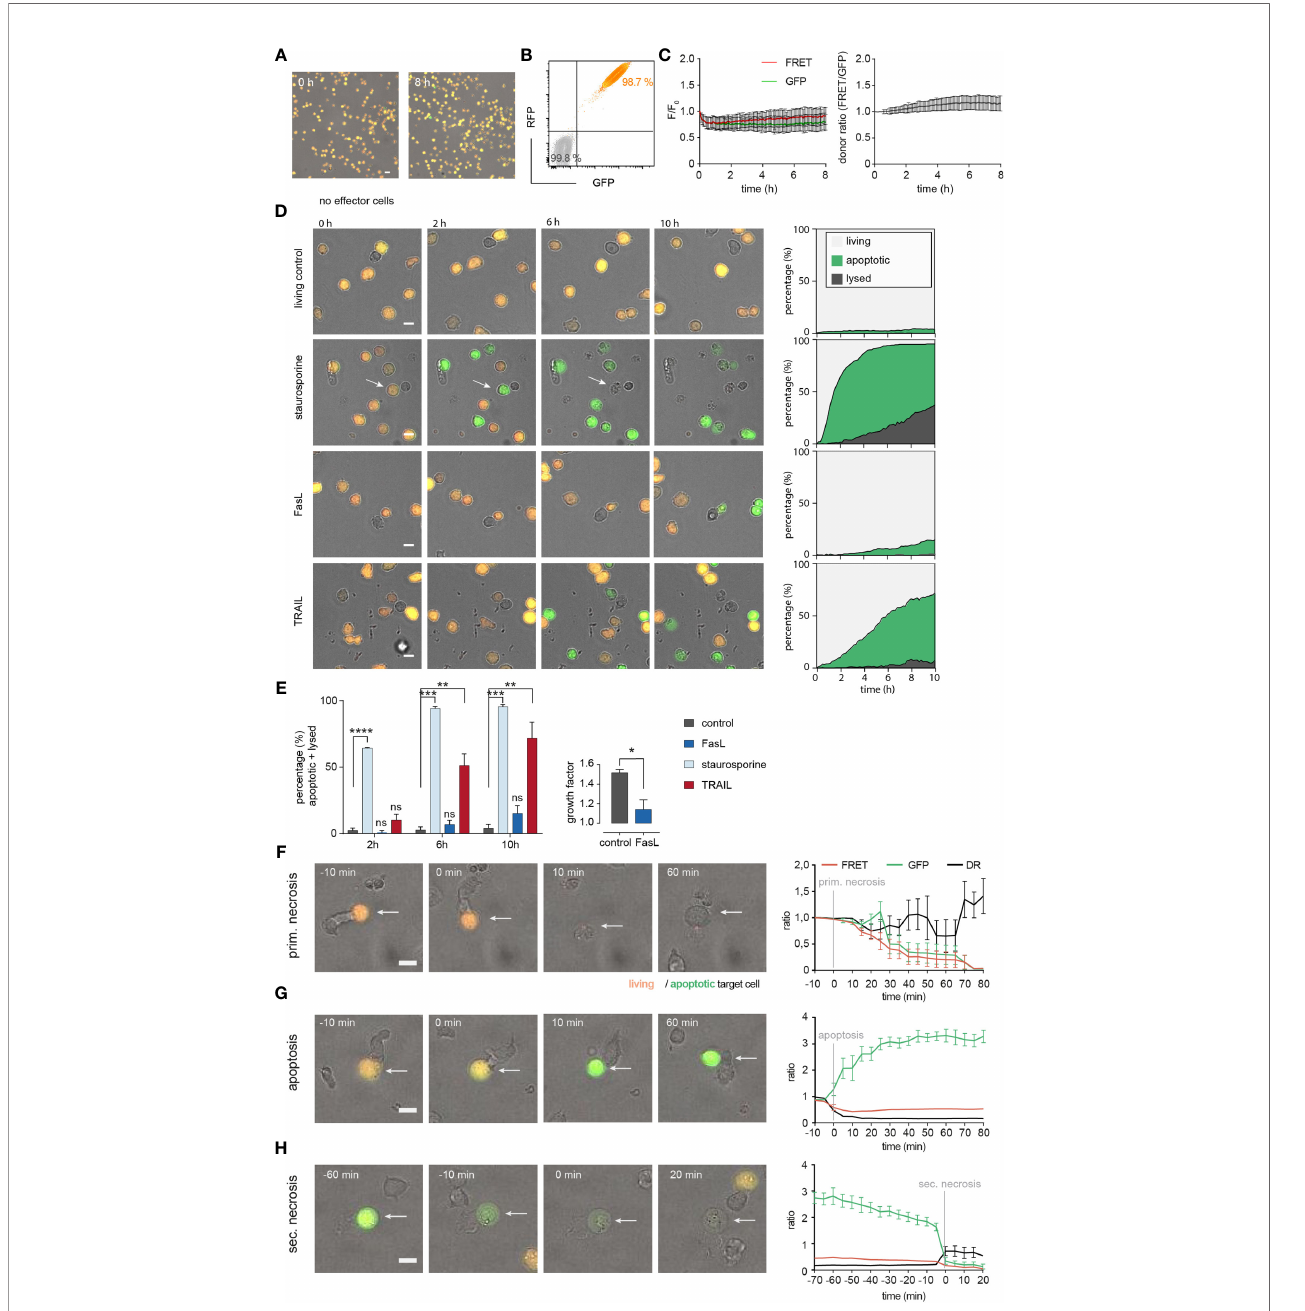
FIGURE 4 | Establishing NALM6 pCasper at single cell level as target cells for SEA-CTL to distinguish between apoptotic and necrotic cell death. (A) Viability of NALM6 pCasper cells at 37° C, 5% CO2 for 8h. Viable cells are orange, apoptotic cells are green. (B) NALM6 cells were stably transfected with pCasper-GR. GFP and RFP fl uorescence of NALM6 pCasper in comparison to non-transfected NALM6 cells (grey) detected by fl ow cytometry as dot blot. (C) Time-resolved averaged normalized GFP and FRET fl uorescence (left) and FRET donor ratio (right) over 8h. (D, E) Detection of apoptosis induction by staurosporine, anti-Fas (Apo1-1) mimicking FasL or recombinant TRAIL. (D) Representative images and automated death plot analysis of NALM6 pCasper cells (control, n=426 cells) over 10h treated with 20 µM staurosporine (n=283 cells), 5 µg/ml APO1-1 (n=254 cells) or 5 µg/ml recombinant TRAIL (n=405 cells) are shown. (E) Quanti fi cation of the fraction of apoptotic and lysed cells and the effect of Apo1-1 treatment (p=0.037) on the growth factor (mean #cells (600 min)/#cells (0-60 min)), single donor, duplicates. Statistical analysis was done using a Friedman test. Speci fi c combinations of substances were used to inhibit perforin and death receptor mediated cytotoxic mechanisms during the assay and by 2h of preincubation. (F) Representative lysis event showing a primary necrosis and time-resolved averaged normalized GFP and FRET fl uorescence of fi ve cells. (G) Representative lysis event showing an apoptosis and time-resolved averaged normalized GFP and FRET fl uorescence of seven cells. (H) Representative lysis event showing a secondary necrosis following an apoptosis and time-resolved averaged normalized GFP and FRET fl uorescence of seven cells. (F-H) SEA-CTL were used as effector cells. Scale bars are 10 µm. * p<0.05; ** p<0.01; ***p<0.001, ****p<0.0001; ns, no signi fi cant